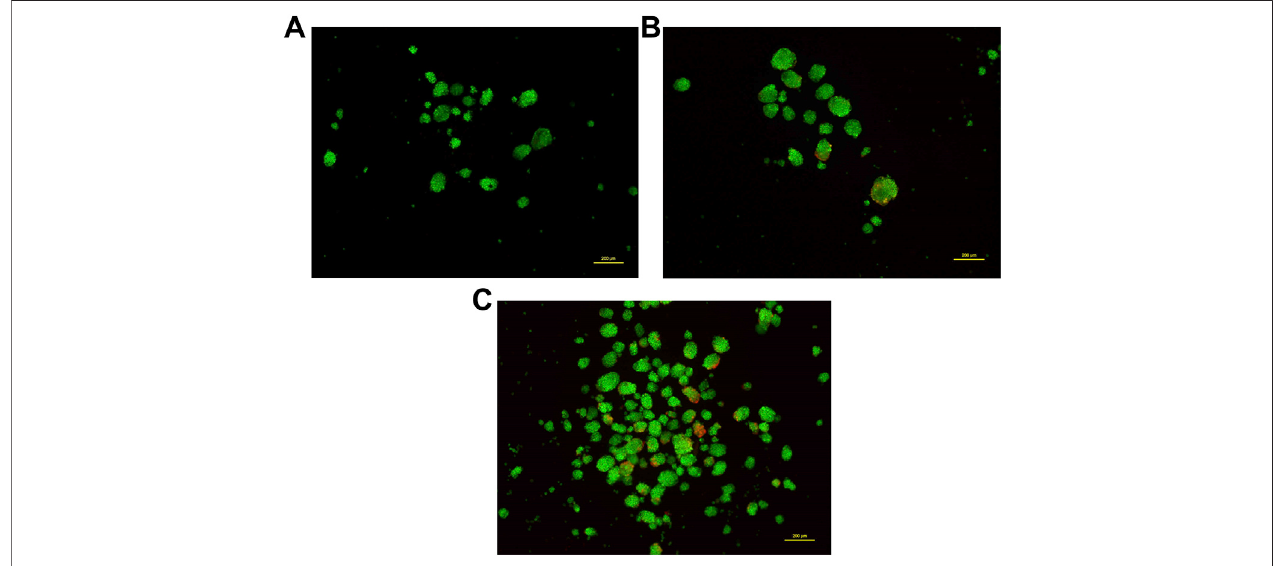
FIGURE 5 | Dual staining using Calcein-AM (live cells, Green) and Propidium iodide (dead cells, Red) at different concentrations. Cells grown as spheroids at passage number 4 were used for this analysis. (A) : 0.5 μ M Calcein-AM and 1 μ M Propidium Iodide. (B) : 1 μ M Calcein-AM and 0.5 μ M Propidium Iodide. (C) : 1.5 μ M Calcein-AM and 1 μ M Propidium